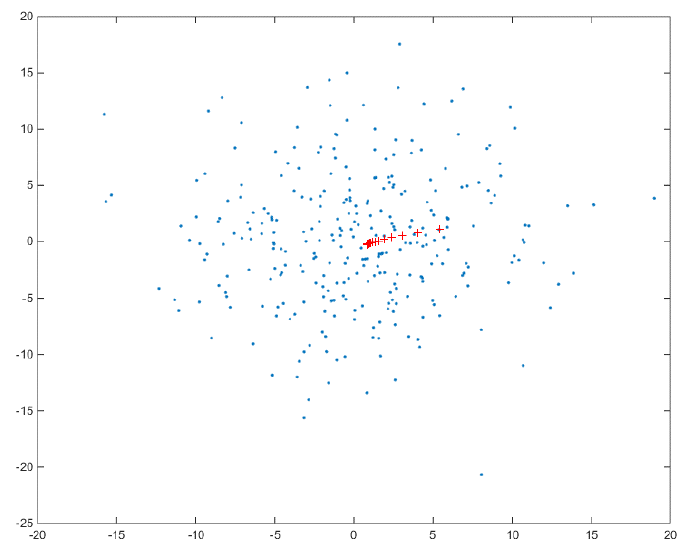
Figure 9. The center point iteration of the kernel function.